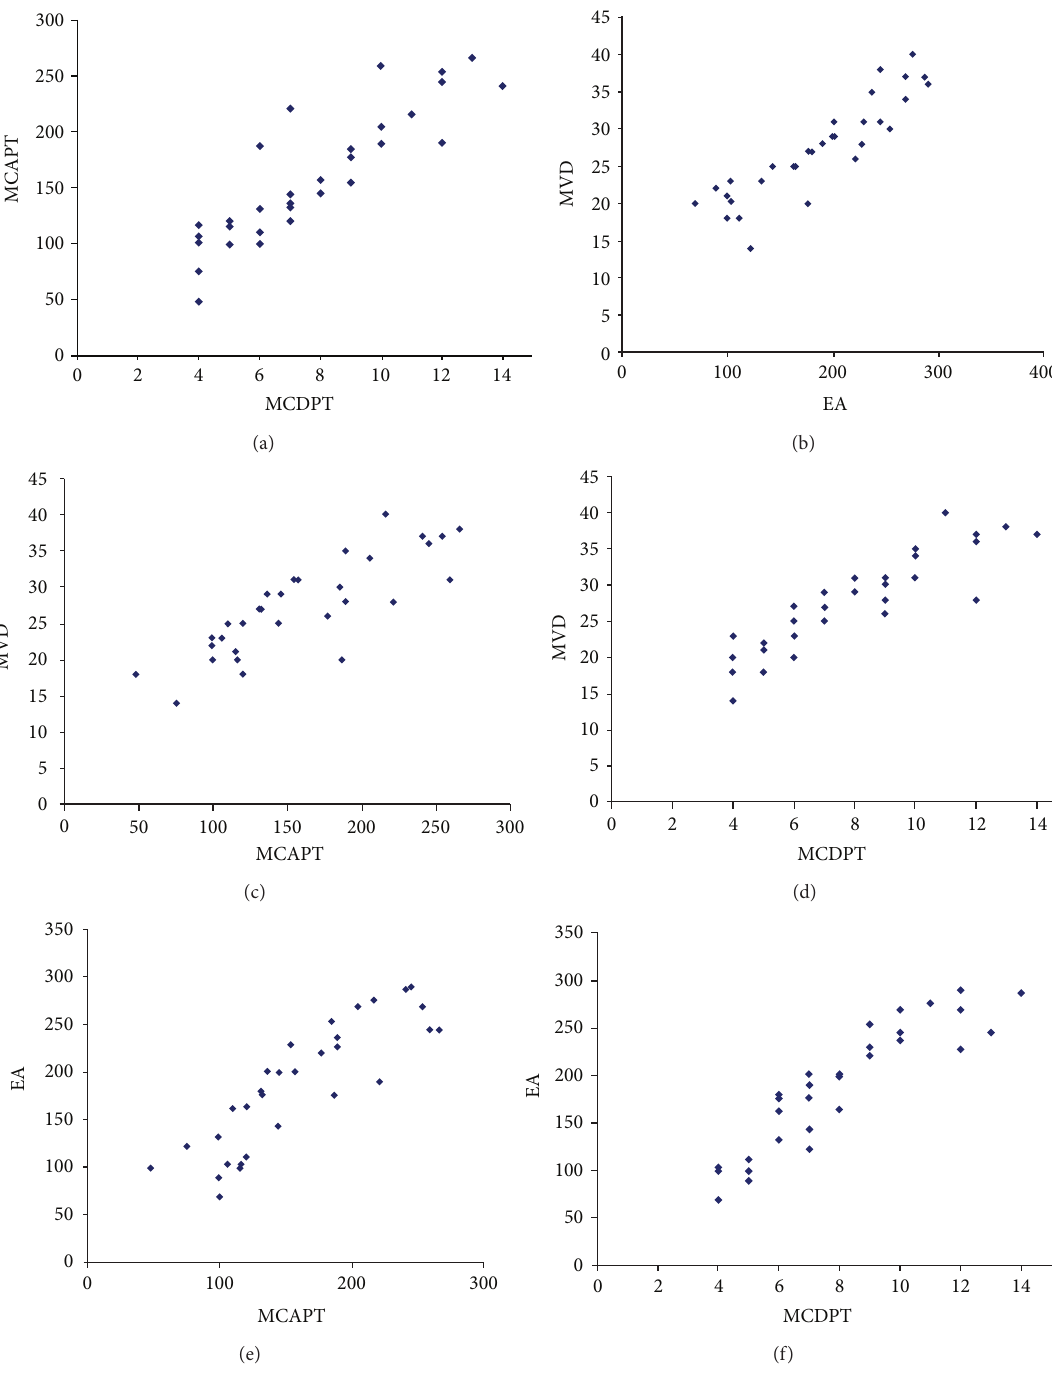
Figure 4: Correlation analysis between MCDPT and MVD ( 𝑟 = 0.81 ; 𝑃 = 0.001 ), MCAPT and MVD ( 𝑟 = 0.69 ; 𝑃 = 0.003 ), MCDPT and EA ( 𝑟 = 0.76 ; 𝑃 = 0.002 ), MCAPT and EA ( 𝑟 = 0.73 ; 𝑃 = 0.002 ), MVD and EA ( 𝑟 = 0.80 ; 𝑃 = 0.001 ), and MCDPT and MCAPT ( 𝑟 = 0.77 ; 𝑃 = 0.001